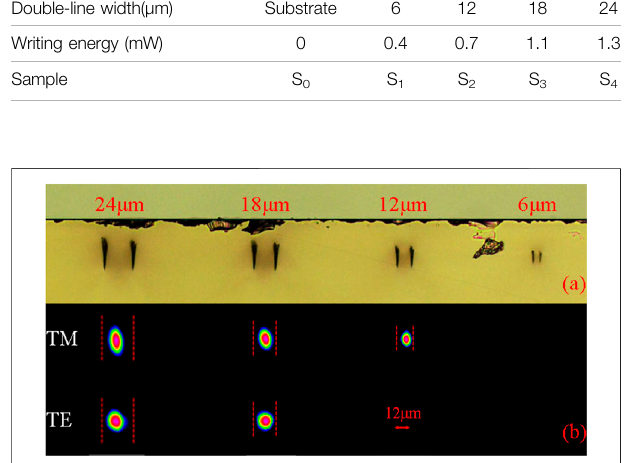
FIGURE2 | (A) Cross-section of the buried channel waveguide structures in Yb:YVO 4 crystals; (B) Model pro fi les of S 2 , S 3, and S 4 at 633 nm under TE and TM